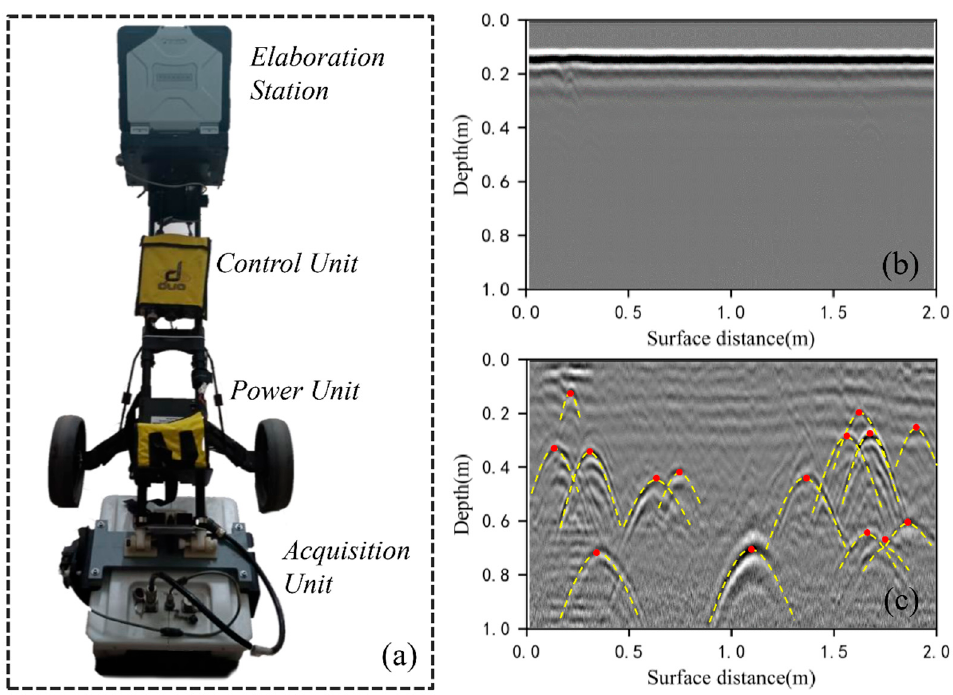
Figure 3. An example of GPR data collection as well as identifying and locating root points in GPR images: ( a ) the GPR system used in this study; ( b ) a raw GPR image collected in the field before preprocessing; ( c ) the lateral coarse roots were located by identifying hyperbolic peaks in the GPR image collected over survey line No. 104 at Site A. Each peak of the hyperbola (indicated by the red dots) indicates the location of a root point.